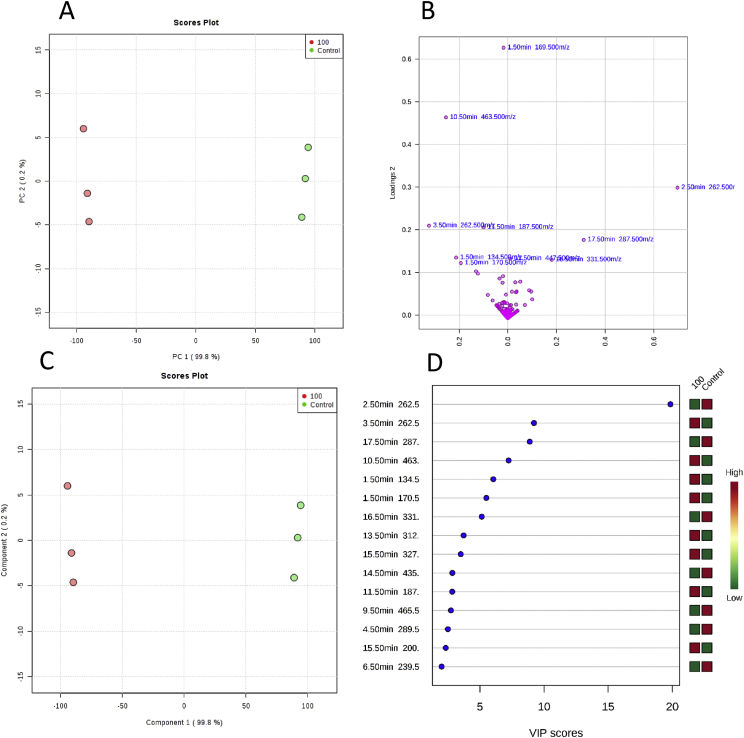
(A) PCA scores plot based on UHPLC−MS data showing separation samples from different irrigation conditions (0 mM - Green; and 100 mM – Red) for the 3rd harvest, together with their respective 95% confidence regions. The explained variances are 99.8 and 0.2% for PC 1 and PC 2, correspondingly. (B) The corresponding loadings scatter plot showing the compounds (represented by their RT) that are correlated to separation in scores plot. (C) PLS-DA of metabolites between groups described above (component 1 and component 2: 99.8 and 0.2%, respectively). (D) Variables important in projection (VIP) scores of 15 top contributors (displayed as RT) to PLS-DA component 1.